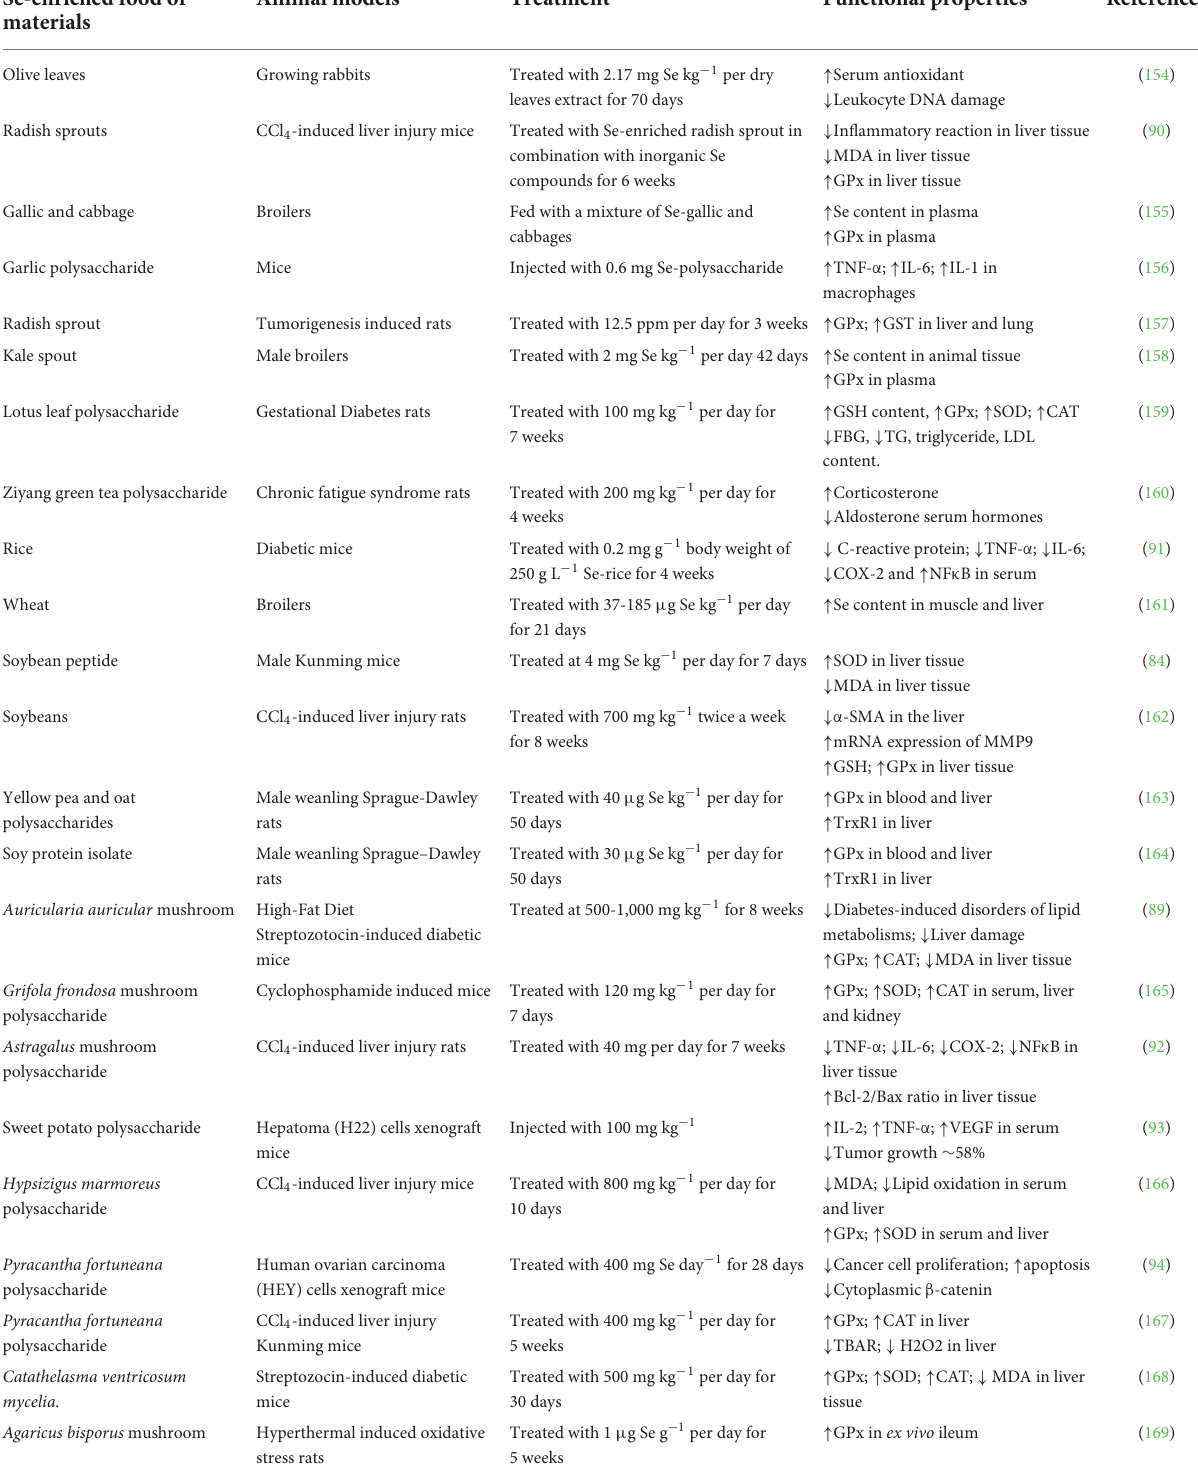
TABLE 3 In vivo studies of Se-enriched plants and other food materials using animal